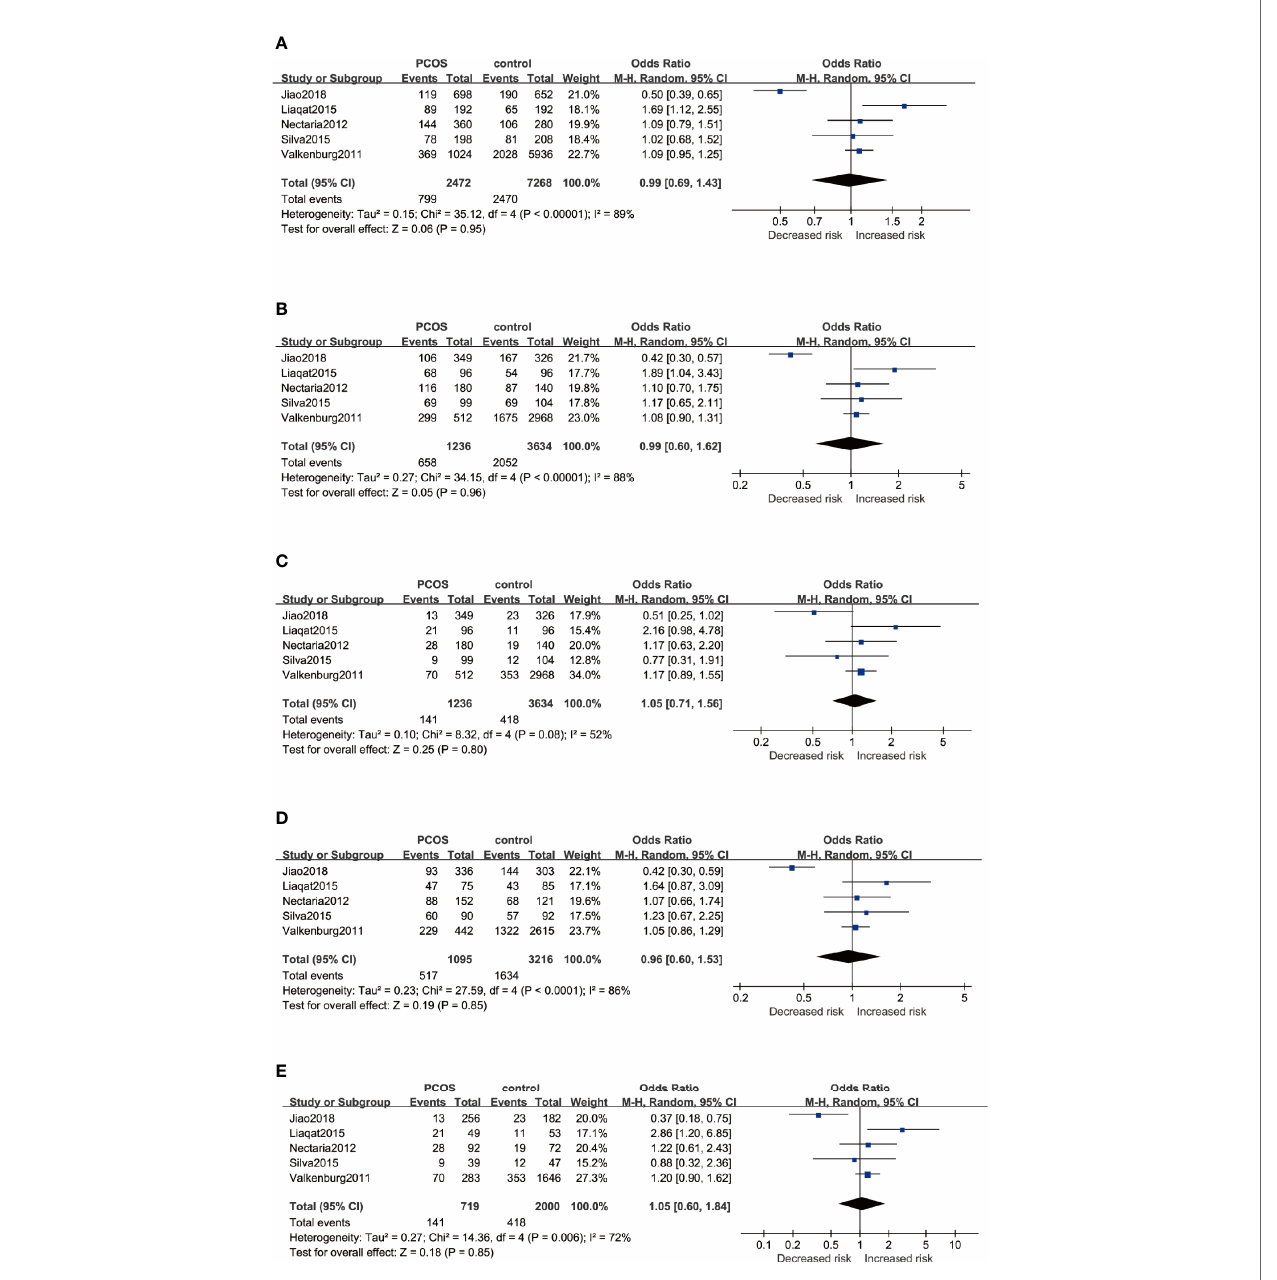
FIGURE 3 | Forest plots of the association between the ESR1 rs9340799 gene and risk of PCOS using different genetic models in overall analysis: (A) Allele model (G versus A), (B) Dominant model (GG+AG versus AA), (C) Recessive model (GG versus AA+AG), (D) Heterozygote model (AG versus AA), and (E) Homozygote model (GG versus AA). In each model, solid squares represent the OR, horizontal lines represent 95%CI, and diamond represents the pooled OR and 95%CI. OR, odds ratios; 95% CI, 95% con fi dence intervals; I 2 , inconsistency